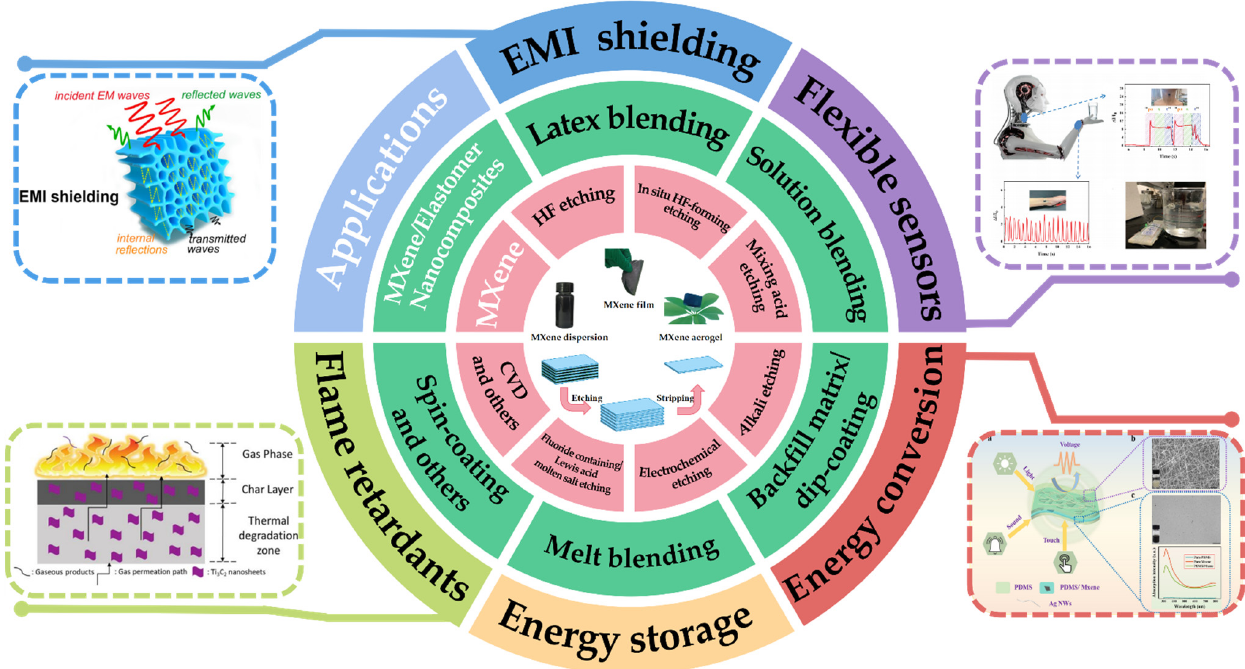
Figure 2. Available preparation methods for MXenes and preparation methods for and applications of MXene/elastomer nanocomposites. (The image of EMI shielding: Reprinted with permission from Ref. [16]. Copyright 2019, copyright Elsevier. The image of flexible sensors: Reprinted with permission from Ref. [29]. Copyright 2021, copyright Wiley-VCH. The image of energy storage and conversion: Reprinted with permission from Ref. [30]. Copyright 2021, copyright Elsevier. The image of flame retardants: Reprinted with permission from Ref. [31]. Copyright 2019, copyright Elsevier).